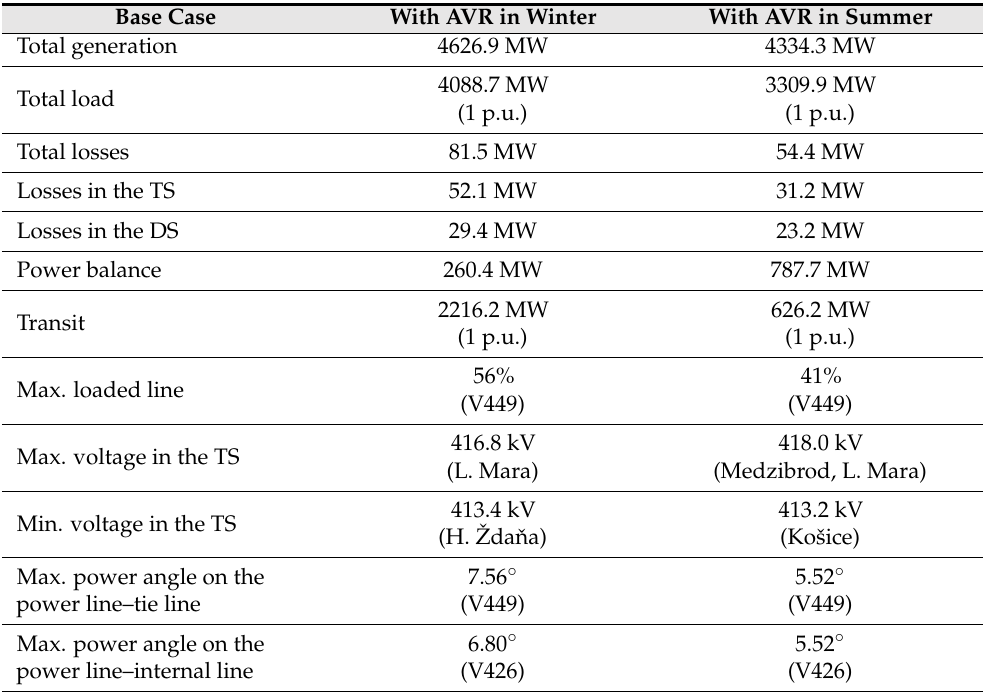
Table 2. Load flow: base cases in winter and